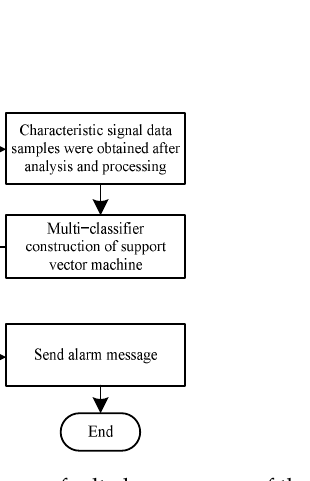
Figure 5. Power performance fault alarm process of the hydraulic hybrid electric vehicle.